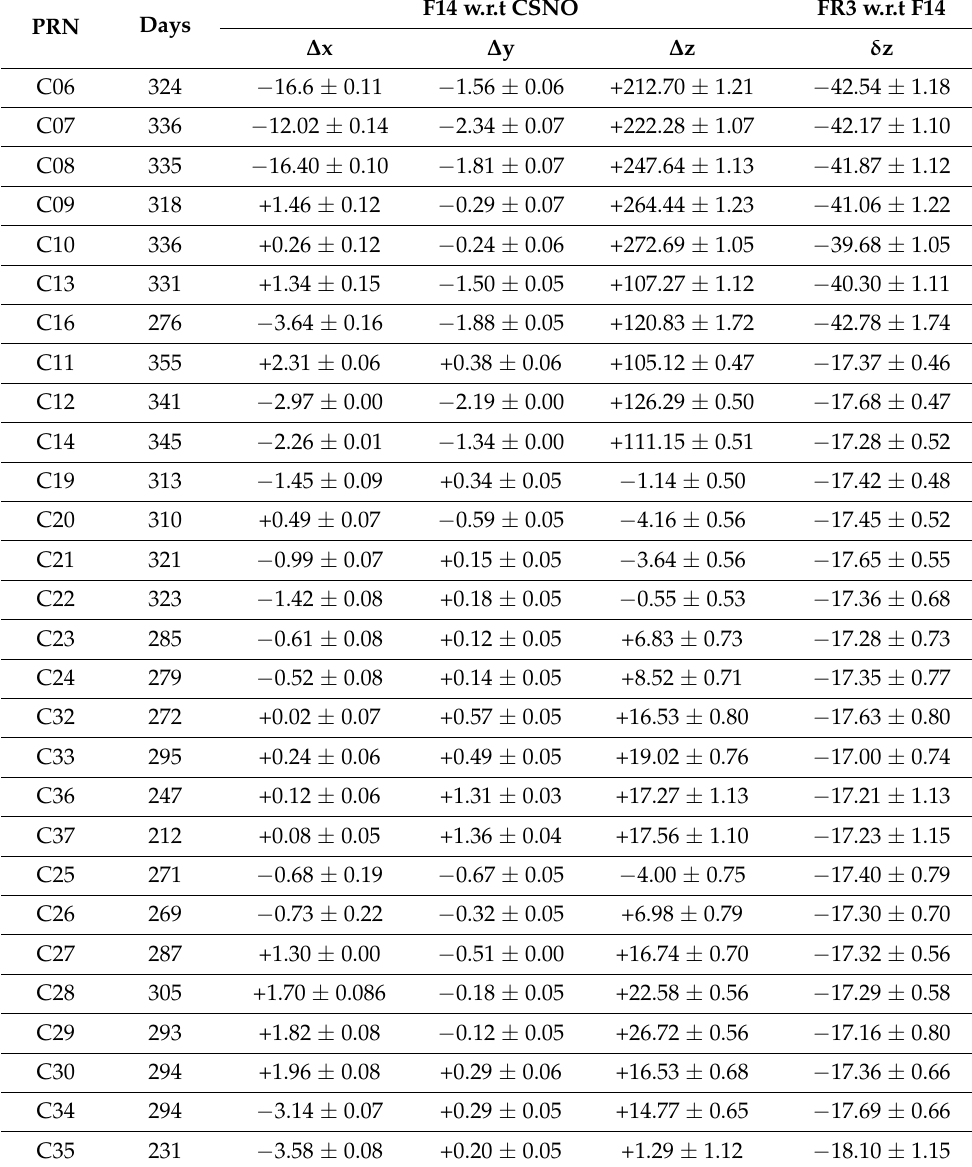
Table 5. Satellite-specific PCOs for F14 and FR3 solutions of BDS IGSO and MEO satellites (unit: